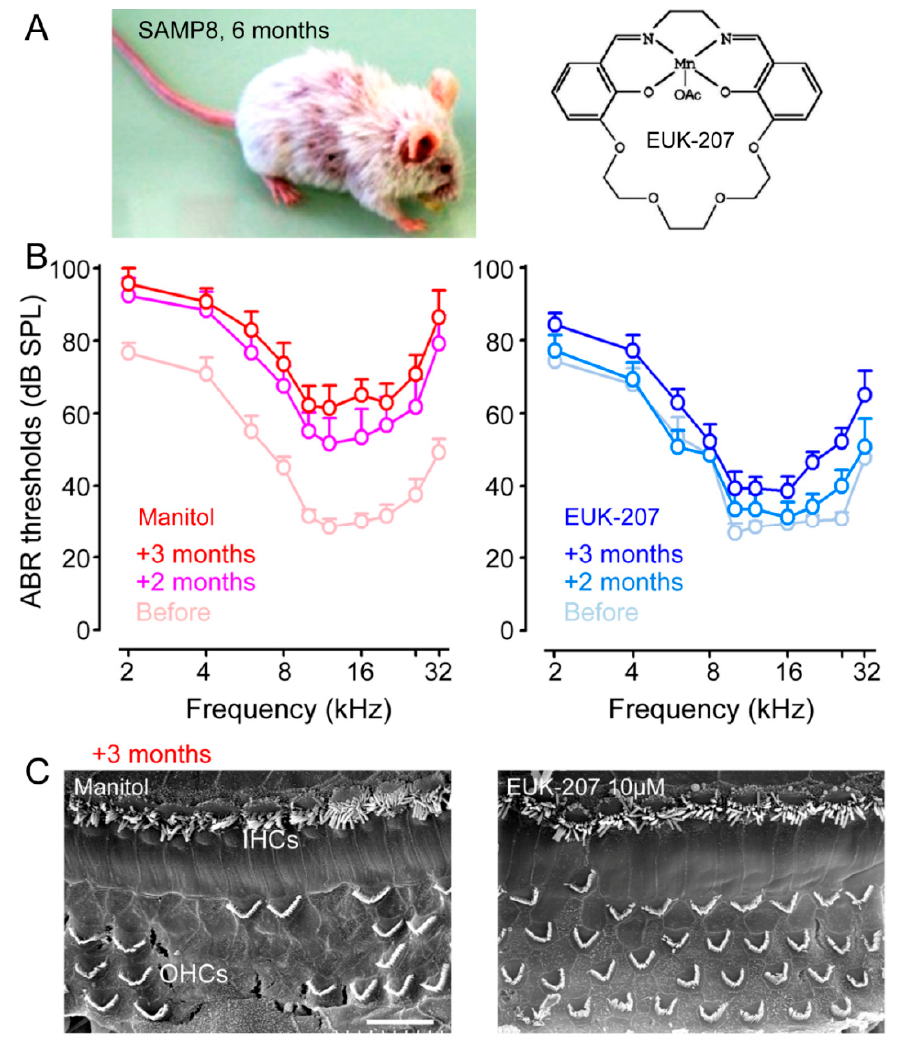
Figure 5. Pharmacological mitigation of ROS prevents loss of hearing and hair cells in SAMP8 mice ( A ) SAMP8 mice and EUK-207. Shown are a SAMP8 mouse aged six months and the synthetic superoxide dismutase / catalase mimetic EUK-207. ( B ) Physiological assessment. The auditory brainstem response (ABR) thresholds recorded before (pale red plot) and after two months (pink plot) and three months (red plot) of Manitol treatments, or before (pale blue plot) and after two months (azure plot) and three months (blue plot) of EUK-207 (10 µ M) treatments. ( C ) Morphological assessment. Representative scanning electron micrographs showing the basal regions of cochleae from Manitol-treated (left panel) and EUK-207-treated (right panel) SAMP8 mice after three months. Scale bar = 15 µ m (Adapted from Benkafadar et al. [70]).